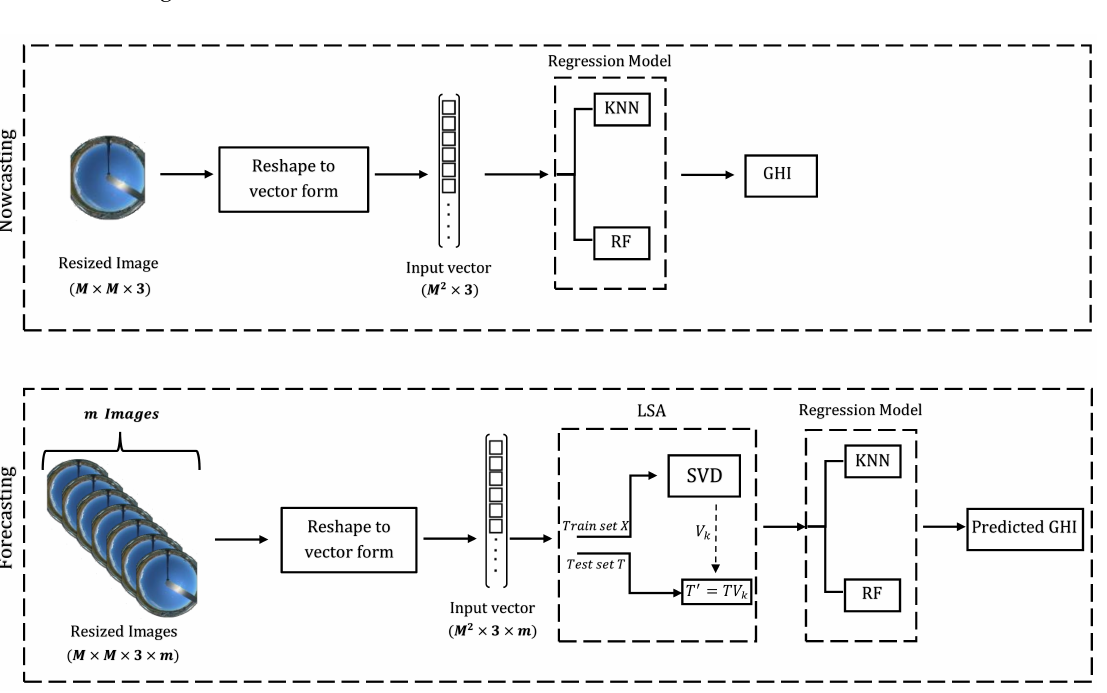
Figure 2. The proposed architectures for nowcasting and